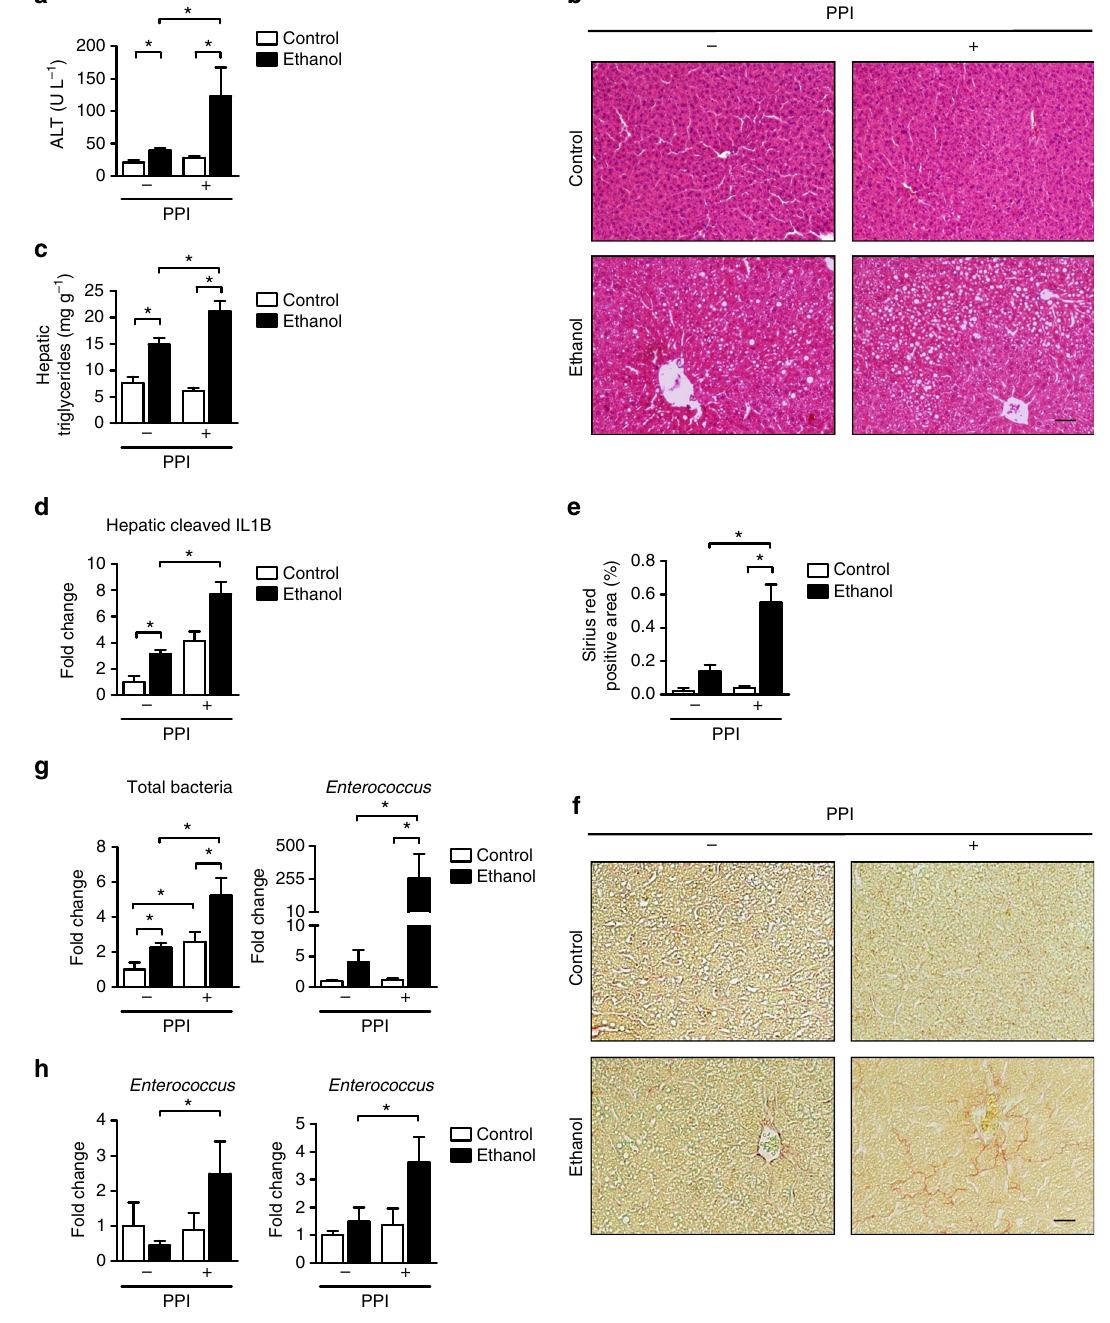
Fig. 4 Pharmacological gastric acid suppression promotes progression of alcohol-induced liver disease in mice. C57BL/6 mice were fed an oral control diet ( n = 4 – 6; 1 – 2 replicates) or ethanol diet ( n = 11 – 18; 1 – 2 replicates) that contained PPI (200 p.p.m.) or vehicle (water) for 9 weeks. a Plasma levels of ALT. b Representative liver sections after hematoxylin and eosin staining. c Hepatic triglyceride content. d Hepatic levels of cleaved IL1B protein ( n = 2 – 5). e Hepatic areas of fi brosis were identi fi ed by staining with Sirius red ( n = 2 – 7); area was quantitated by image analysis software. f Representative Sirius red-stained liver sections. g Total bacteria and total amount of enterococci in feces. h Enterococcus in mesenteric lymph nodes (MLN) and liver, assessed by qPCR. Scale bars = 100 μ m. Results are expressed as mean ± s.e.m. For a , c – e , g , h signi fi cance was evaluated using the unpaired Student t -test or Mann – Whitney U -statistic test. * P <